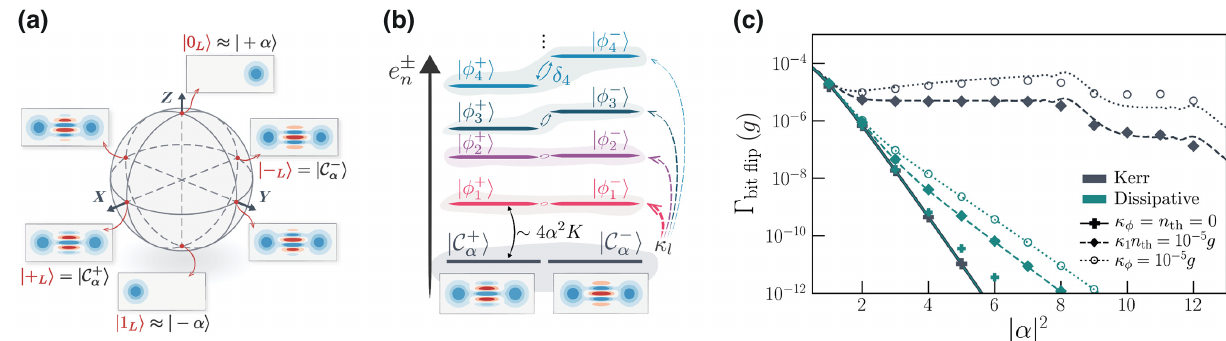
= κ + | α | 2 κ φ readily brings the system towards a superposition 1 n th l = | e − − e + | . (c) Bit-flip error rate of an idle cat n n n